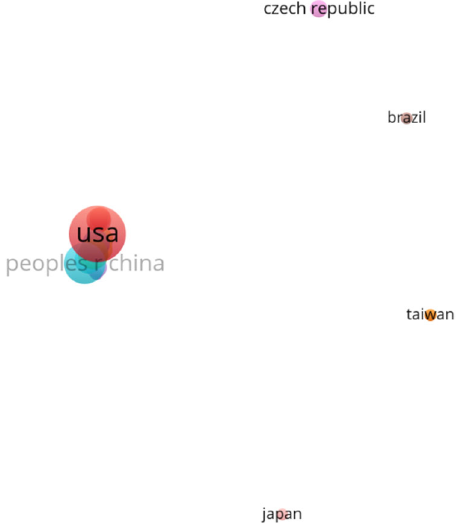
Figure 8. Country/region co ‐ authorship map for prenatal exposure to air pollution publication.